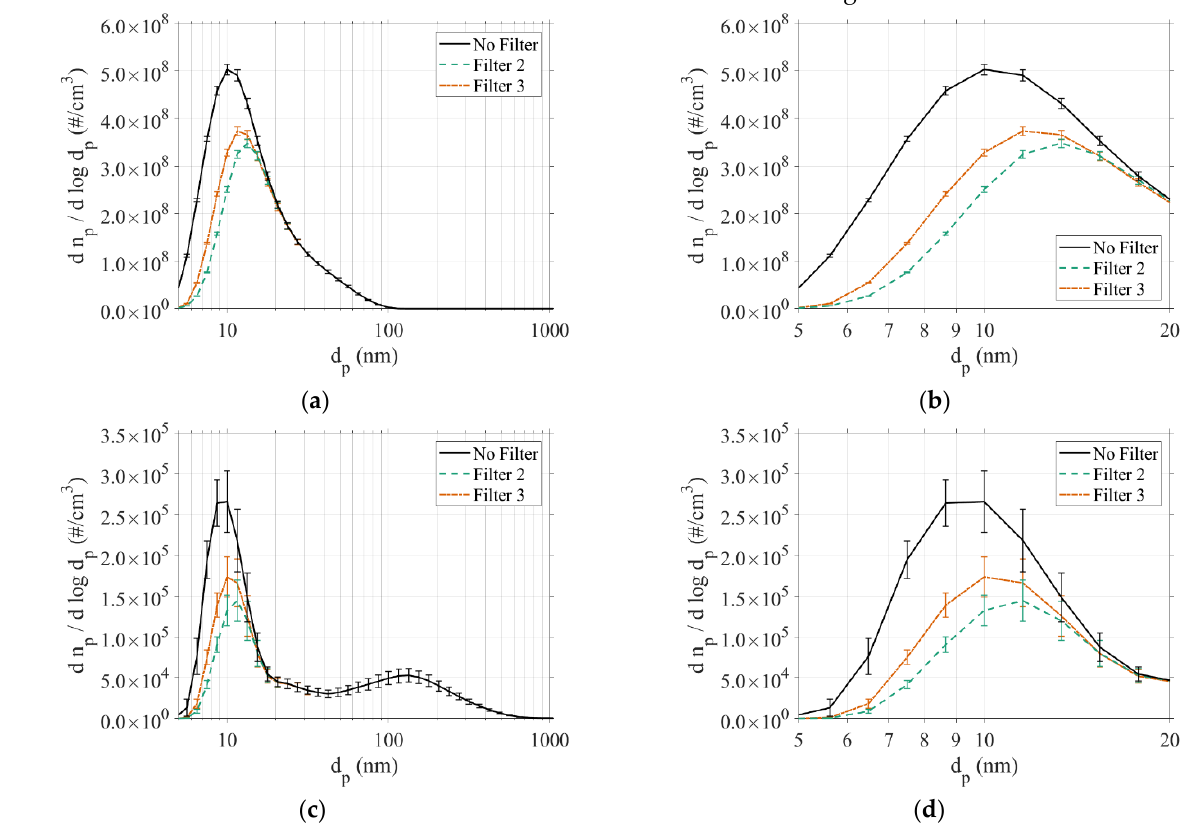
Figure 3. Particle size distributions (PSDs) for DMS measurements with the catalytic stripper and applied particle loss correction, for fast-idle operation at 1250 rpm ( a , b ) and 40 Nm at 2250 rpm ( c , d ). The subfigures ( b , d ) show enlarged PSD sections below 20 nm of ( a , c ), respectively. Filter 2: d 50 = 10 nm, d 90 = 15 nm. Filter 3: d 65 = 10 nm, d 90 = 15 nm. Error bars indicate 95% confidence intervals.